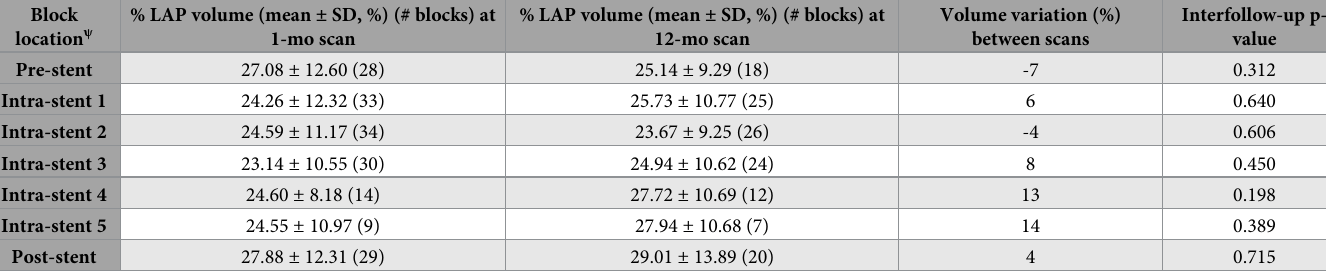
Table 10. Relative LAP volume at 1- and 12-month follow-ups by block location (pre-, intra 1-, 2-, 3-, 4-, 5-, and post-stent blocks). Block location ψ